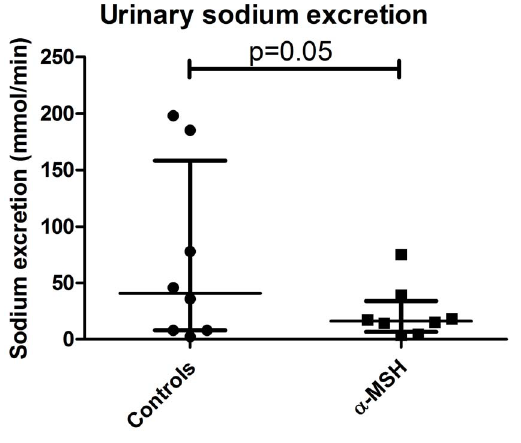
Figure 4. Effect of a -MSH on Sodium excretion. Sodium excretion per minute was reduced by a -MSH (*=p , 0.05).